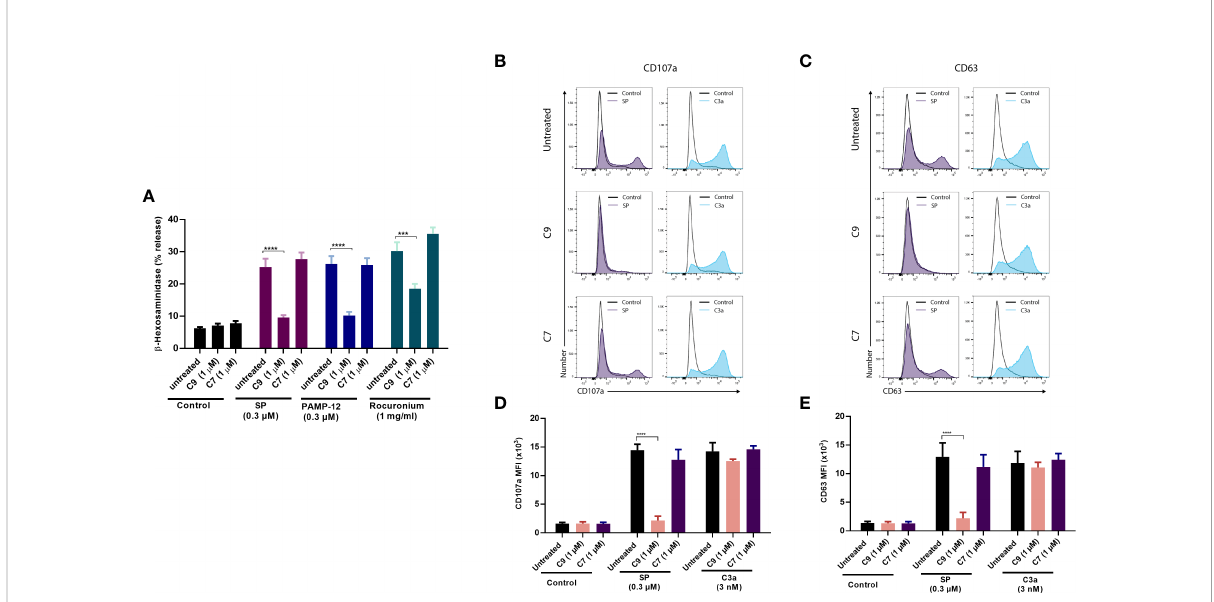
FIGURE 2 C9 inhibits MRGPRX2-mediated MC degranulation in LAD2 cells without affecting the C3aR response. (A) LAD2 cells were preincubated with C9 and inactive analog C7 (1 µM, for 5 min) then exposed to agonists at the indicated concentrations, and degranulation was assayed by measuring the release of b -hexosaminidase. (B, C) Cells were stimulated with SP (0.3 µM) or C3a (3 nM) for 5 min in the presence or absence of C9 or C7. Cell surface expression of CD107a and CD63 were determined by fl ow cytometry. Representative histograms of three independent experiments are shown. (D, E) The mean fl uorescent intensity (MFI) levels of CD107a and CD63 are shown. Data are expressed as mean ± SEM. Statistical signi fi cance was determined by two-way ANOVA test at a value *** P < 0.001 and **** P <